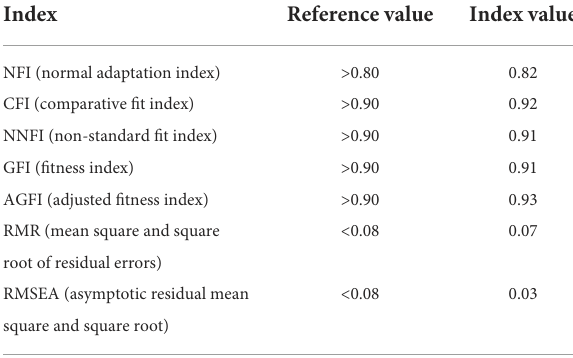
TABLE 1 Confirmatory factors for the fit indices of the ICC evaluation scale for Chinese college